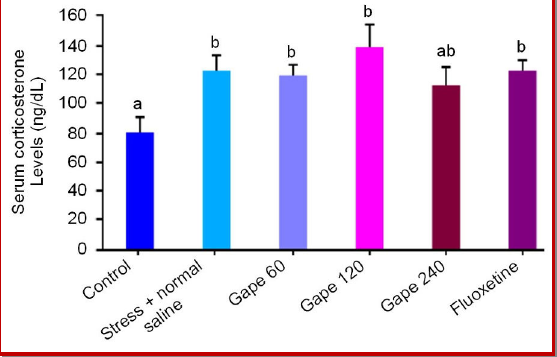
Figure 4: Effect of intraperitoneal injection of different doses of fluoxetine and grape seed oil on serum corticosterone